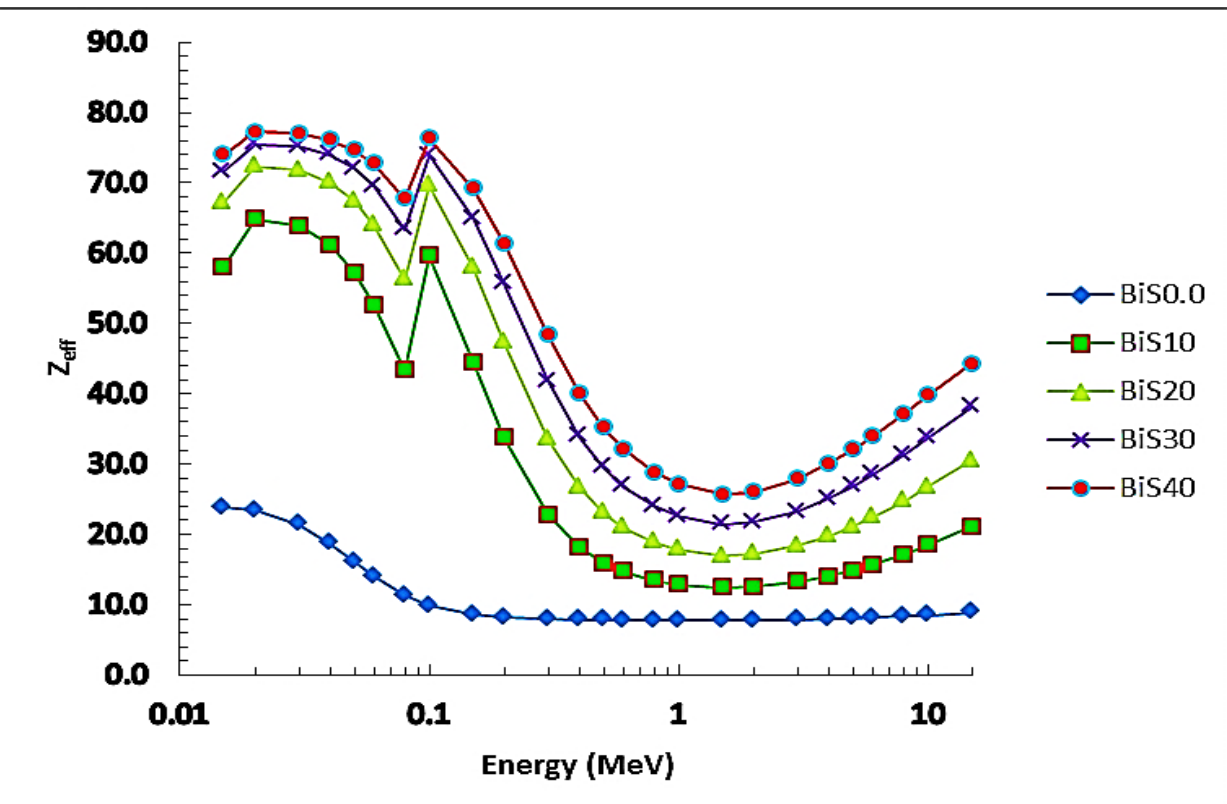
Figure 11. Z eff depending on photon energy for all present glass samples.